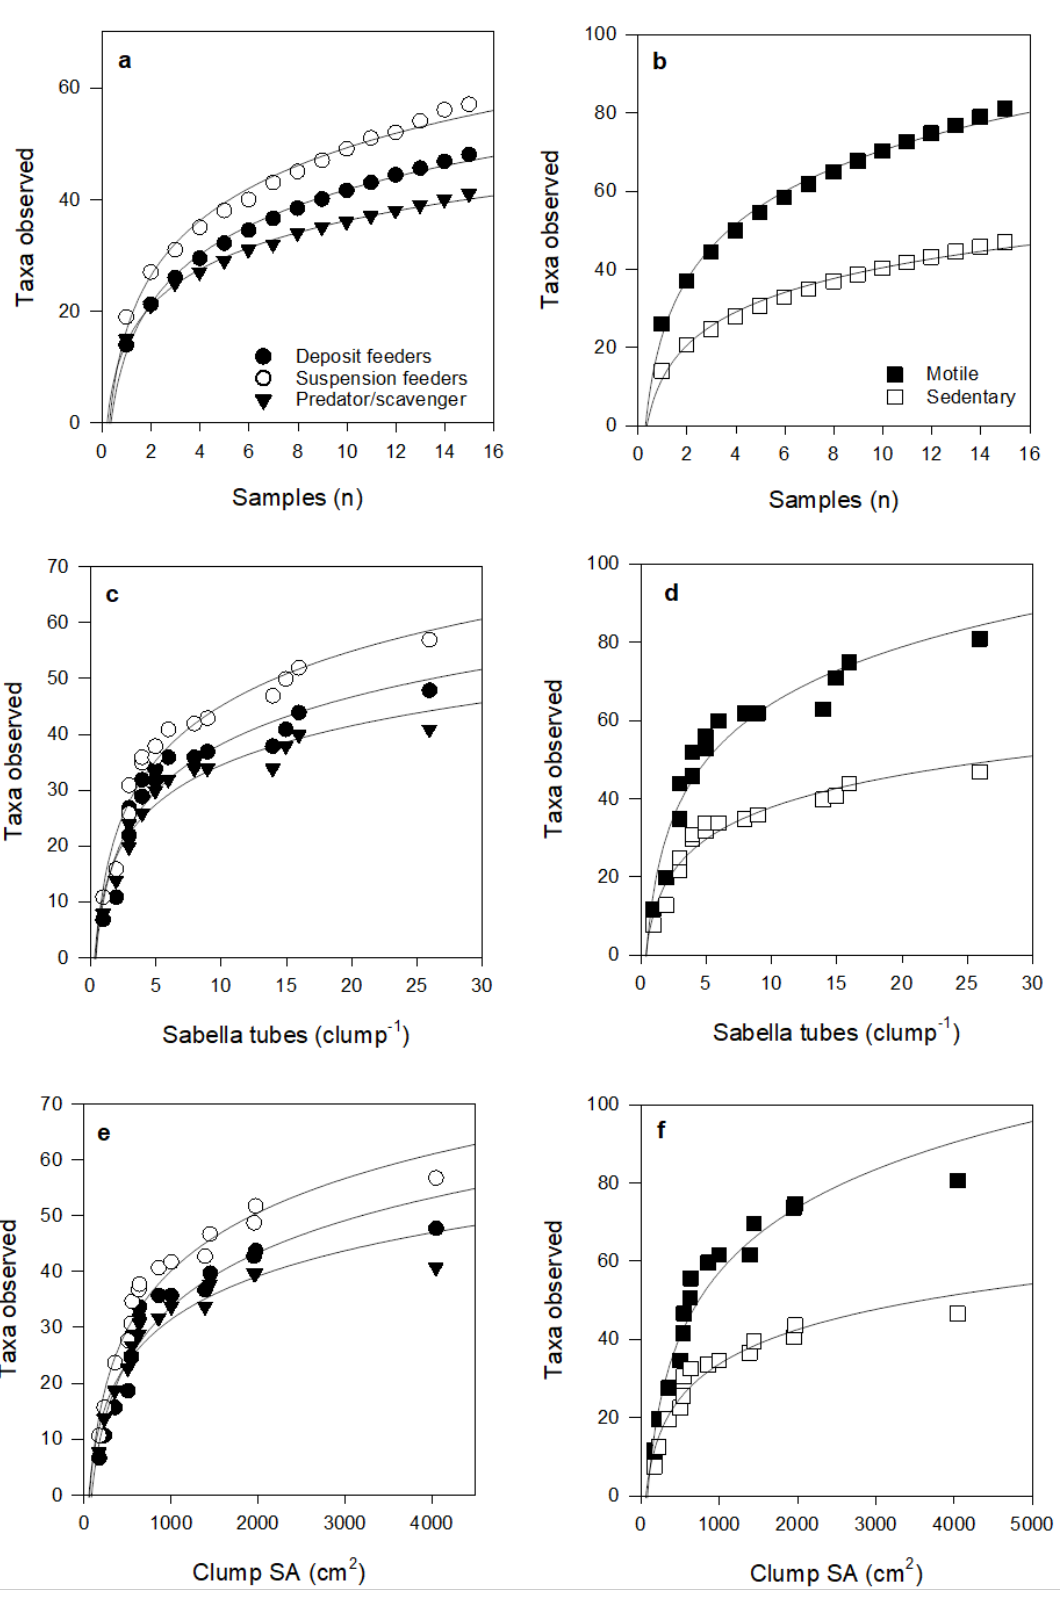
Figure 6. Species accumulation curves for taxa according to feeding mode and motility, with increasing number of Sabella clump samples ( a , b ), number of Sabella tubes per clump ( c , d ), and Sabella clump surface area ( e , f ). Fitted curves all follow logarithmic equations (all R 2 > 0.9), see Table S2 for further detail.